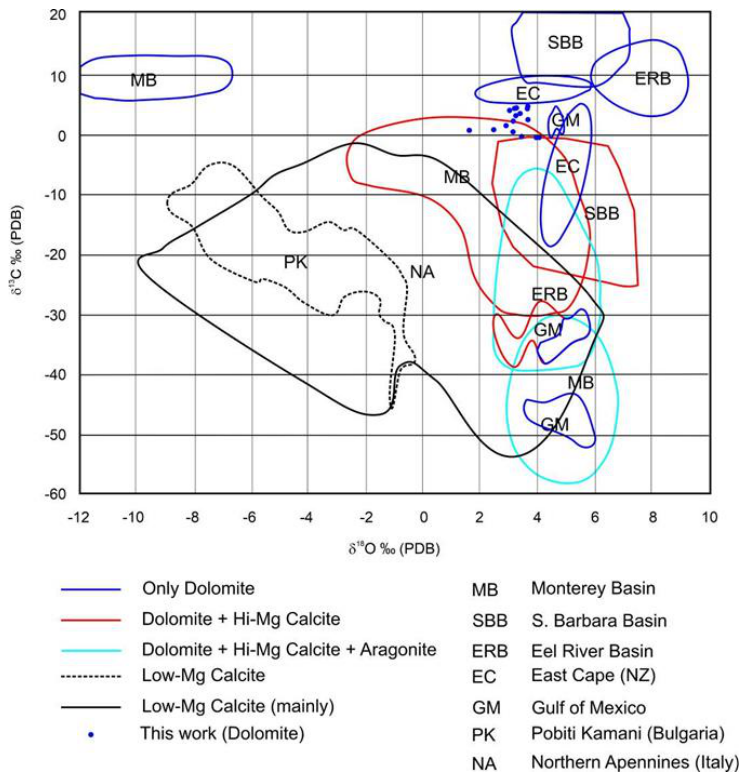
Figure 8. Plot of carbonate conduit mineralogy and stable carbon ( δ 13 C) and oxygen ( δ 18 O) isotope values from different world examples. Data are from [2,12,15,57,58].